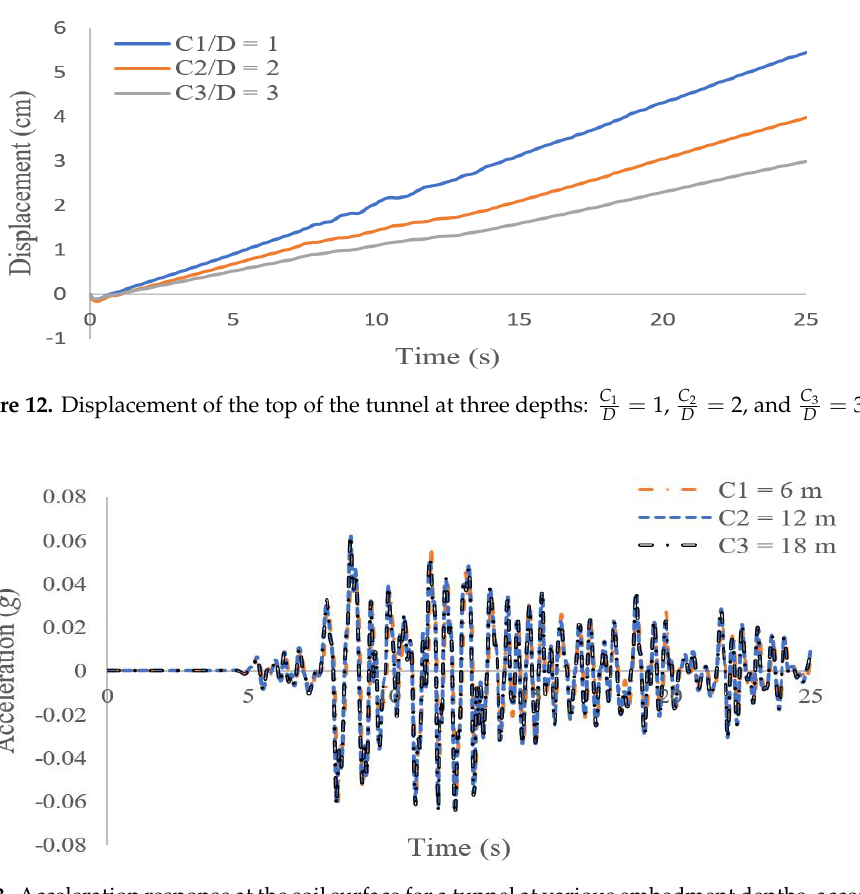
Figure 13. Acceleration response at the soil surface for a tunnel at various embedment depths, according to the kinematic hardening